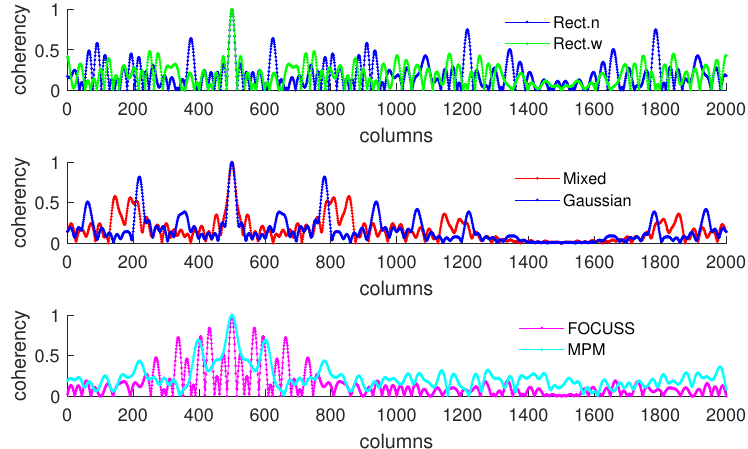
Figure 7. Coherence curve of each subarray generated in Simulation 1 at direction θ = π /6 when σ p =